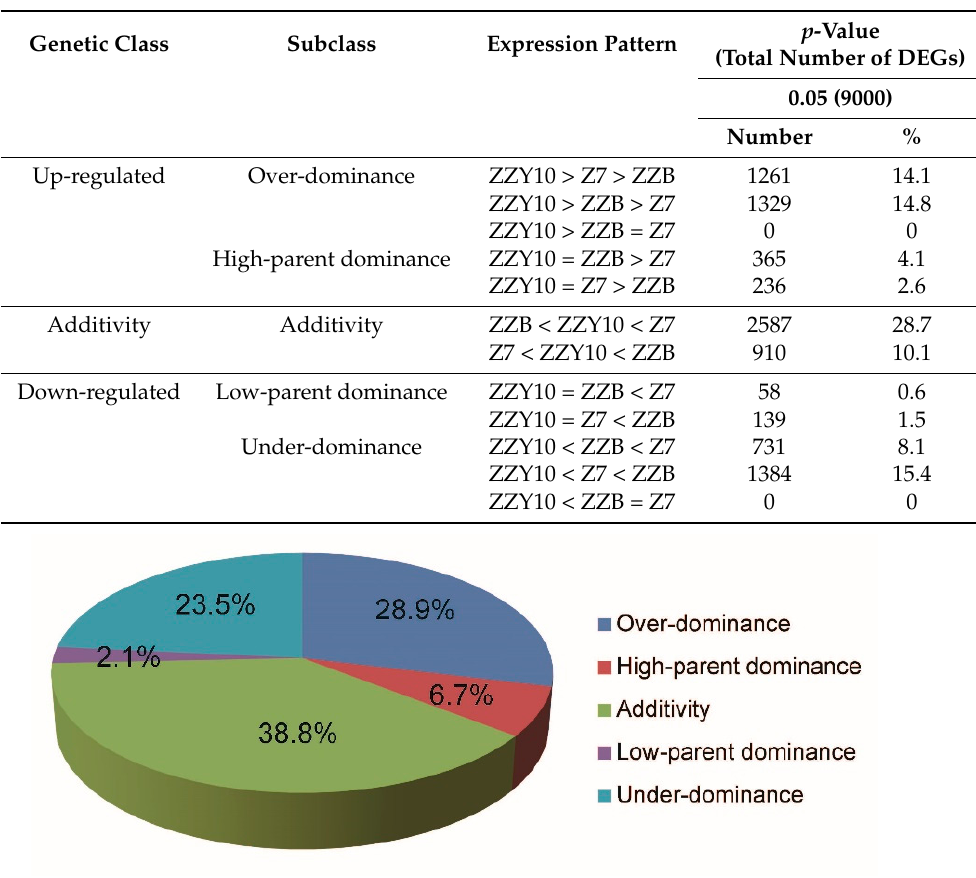
Table 3. DEGs between the hybrid ZZY10 and its parents.